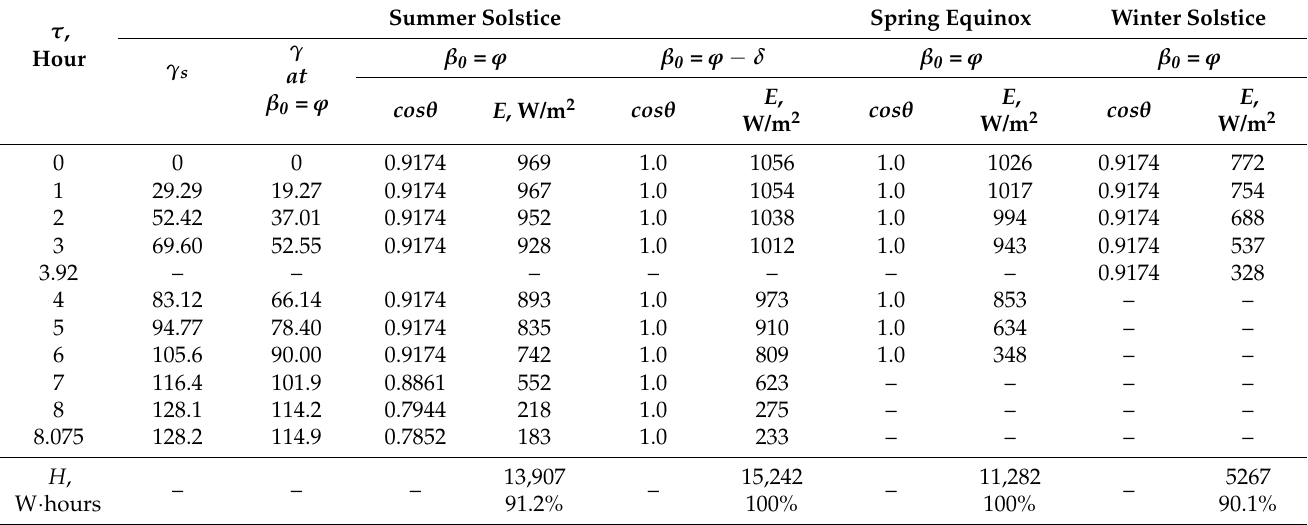
Table 7. Orientation efficiency of the tracking surface while rotating around the polar axis, cos θ (own